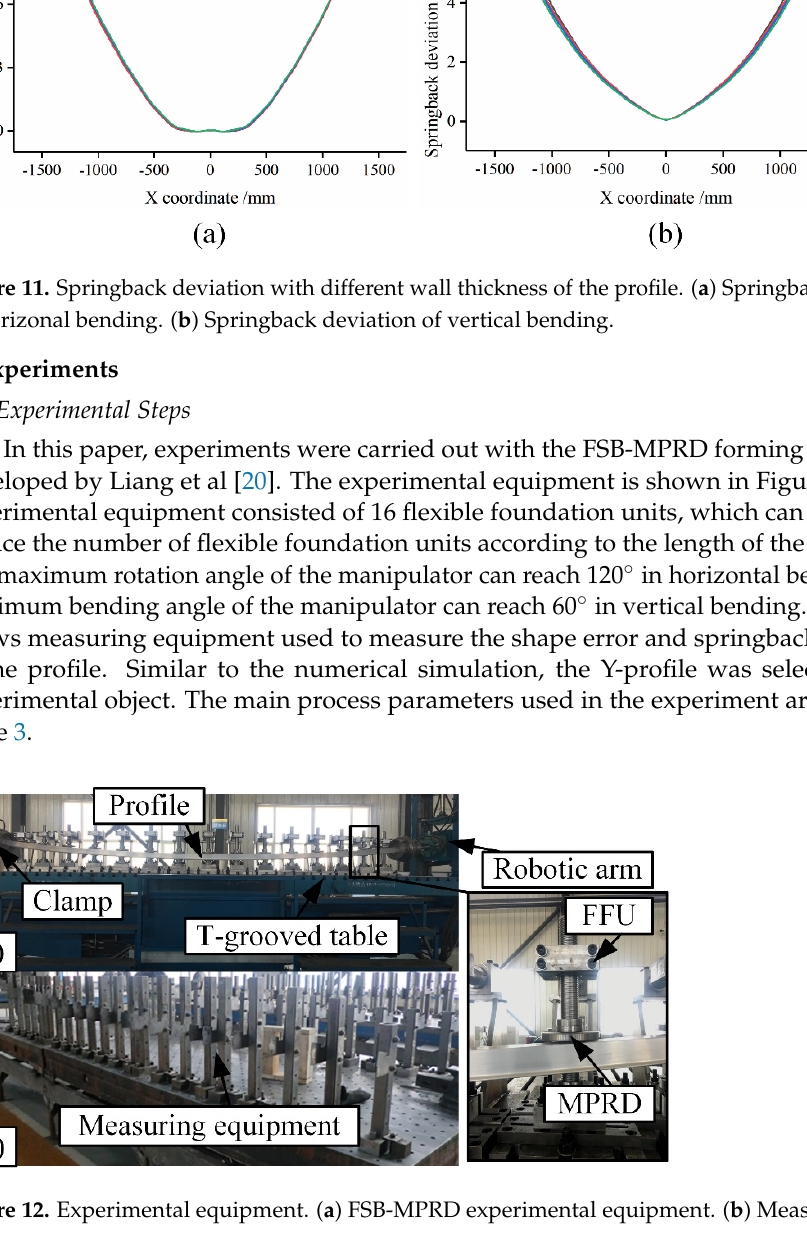
10 of 14 Figure 10. Springback deviation with different radii of roller dies. ( a ) Springback deviation of horizonal bending. ( b ) Springback deviation of vertical bending. 4.5. Influence of Wall Thickness of Profile on Springback When other process parameters remain unchanged, the influence of a different wall thickness of the profile on the springback deviation can be studied. Figure 11 shows the springback deviation of horizontal bending and vertical bending of the Y-profile with different wall thickness. It can be seen from Figure 11a that although the wall thickness of the profile was different, the springback deviation curves of horizontal bending of the profiles basically coincided. This is mainly because in the horizontal bending process, the target curvature of the profile is large, and the deformation is severe. Therefore, the wall thickness of the profile had little influence on the springback deviation of horizontal